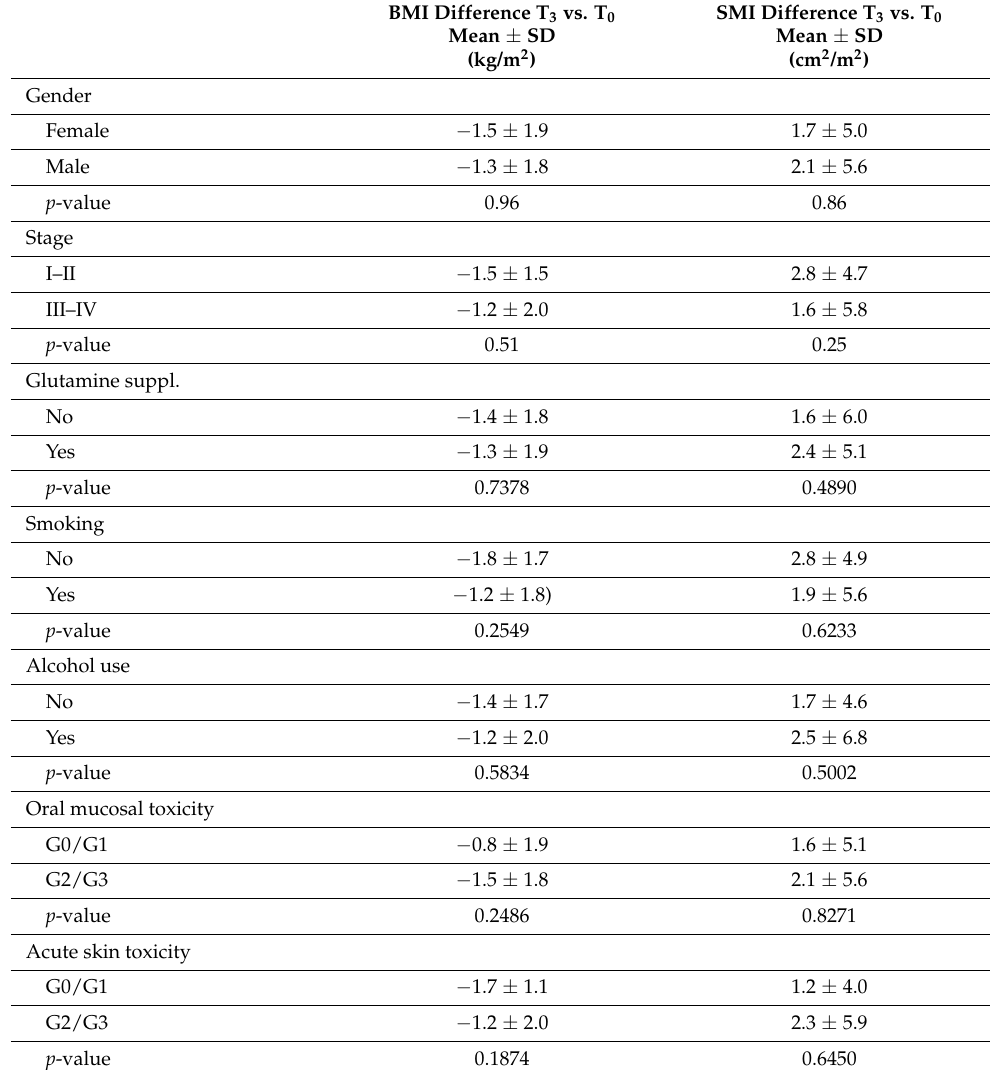
Table 2. BMI and SMI variation in relation to patient and disease